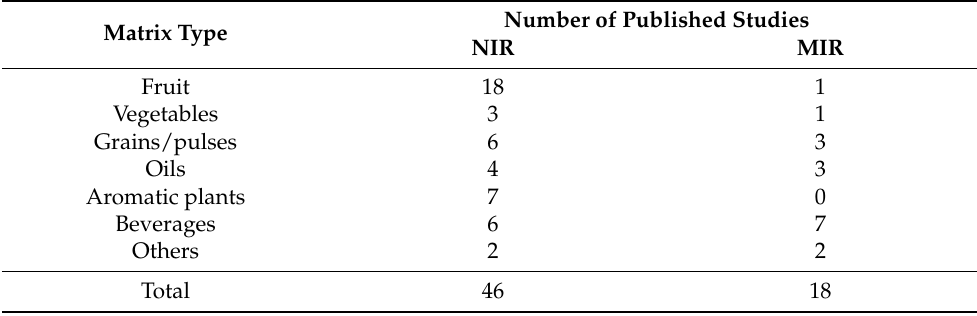
Table 4. Number of studies included in this review, broken down by matrix type. If the same study used both NIR and MIR spectroscopy, it was counted separately in each